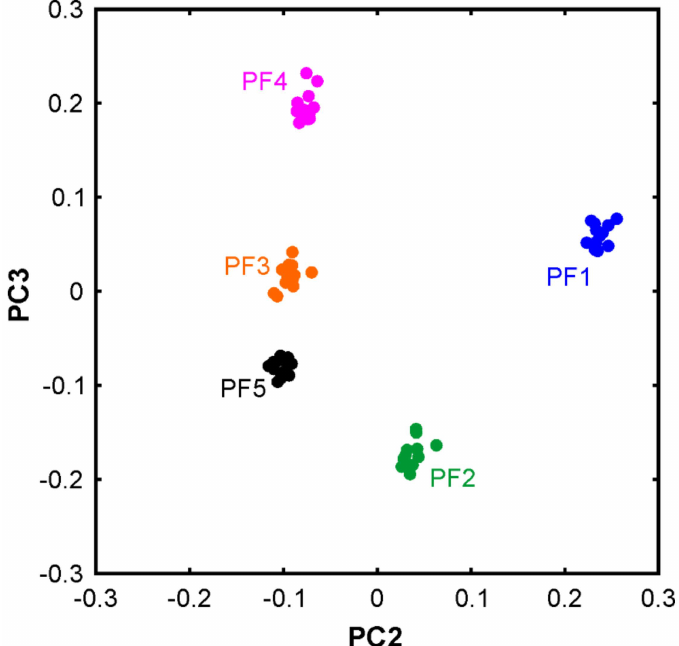
Figure 4. Principal component analysis of the five passion fruit oil samples. Variance covered: PC1 (99.9210%), PC2 (0.0285%), and PC3 (0.0064).